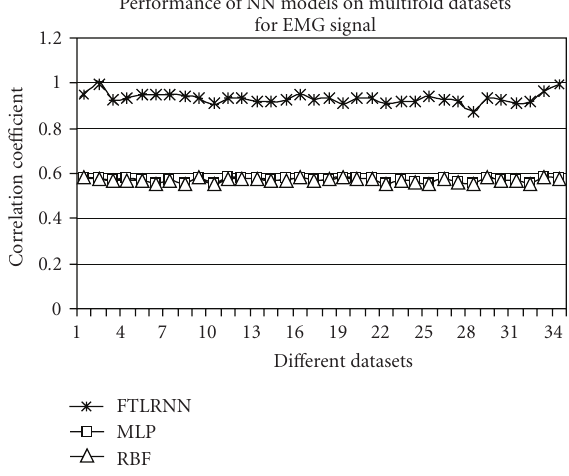
Figure 18: Performance of NNs on di ff erential learning.